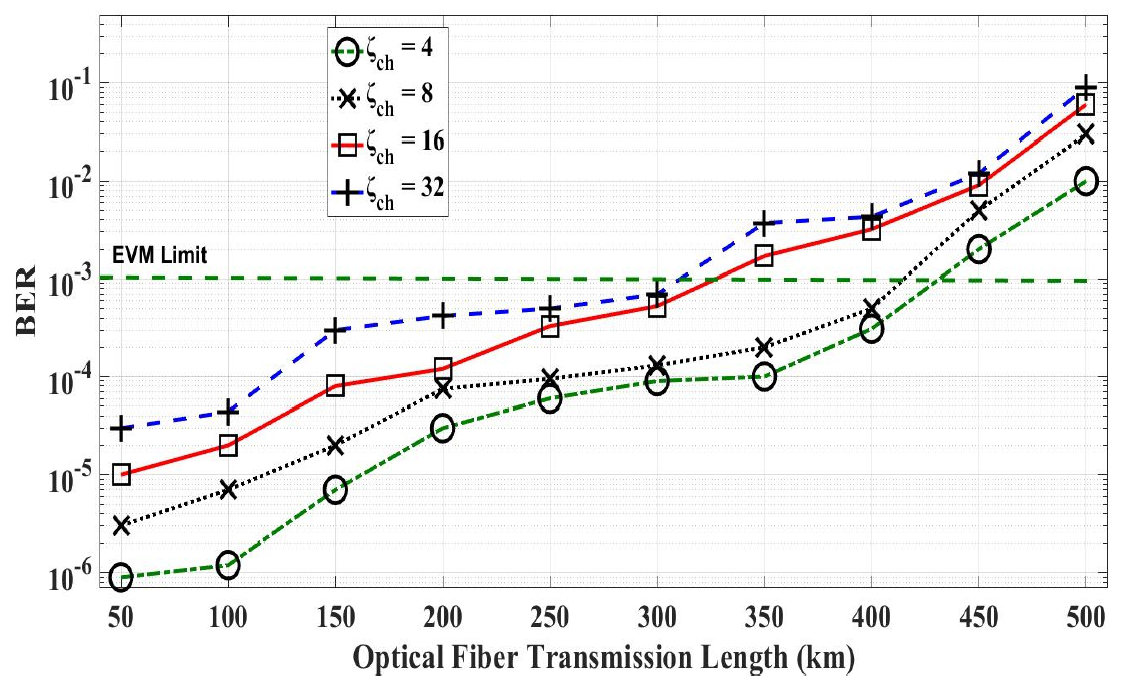
Figure 10. BER results for different fiber lengths with 4, 8, 16, and 32 channels (with 50 GHz channel